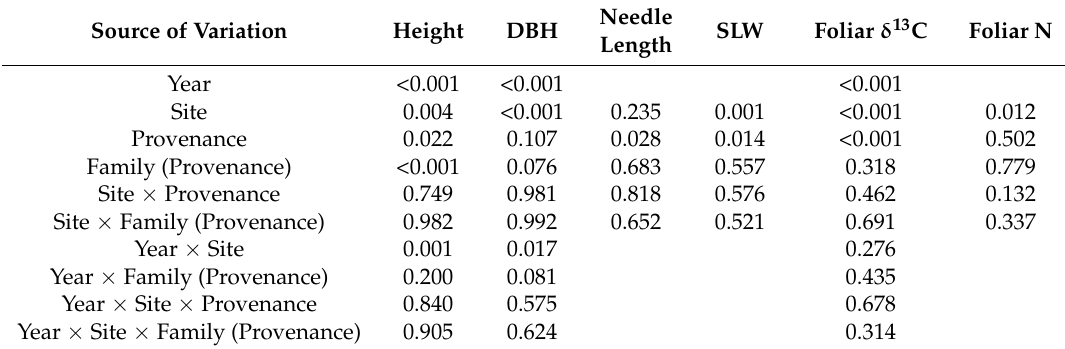
Table 2. Probability values for main and interactive effects of year (for repeatedly measured variables), provenance test site, provenance, and family nested within provenance on tree size and needle traits of longleaf pine.